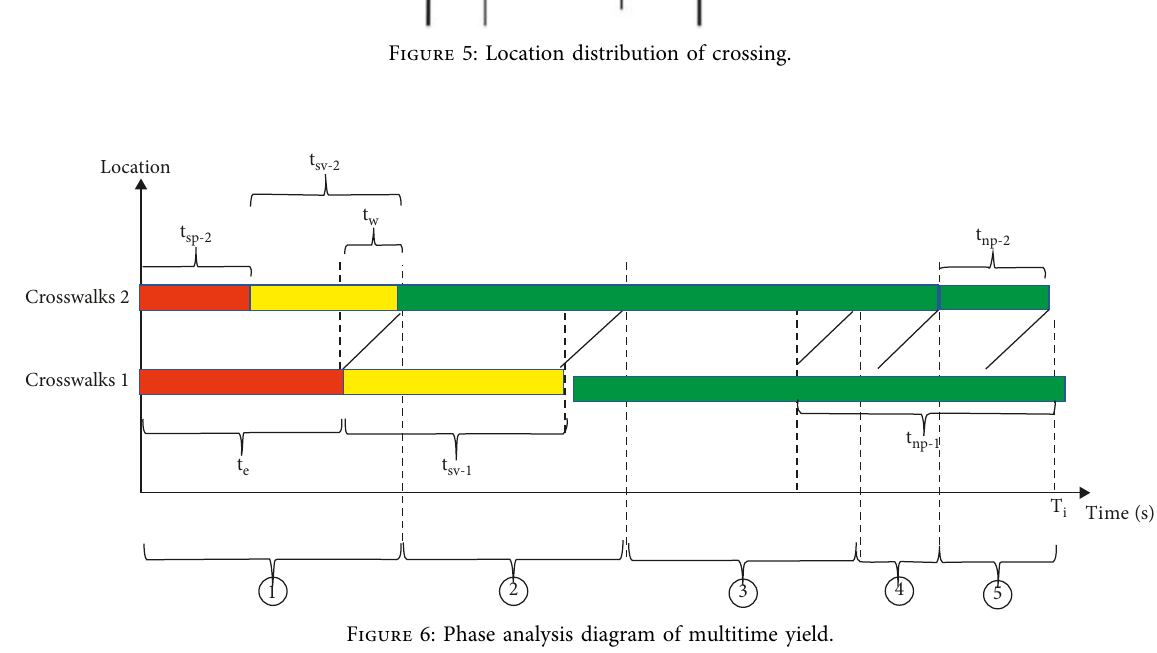
Figure 6: Phase analysis diagram of multitime